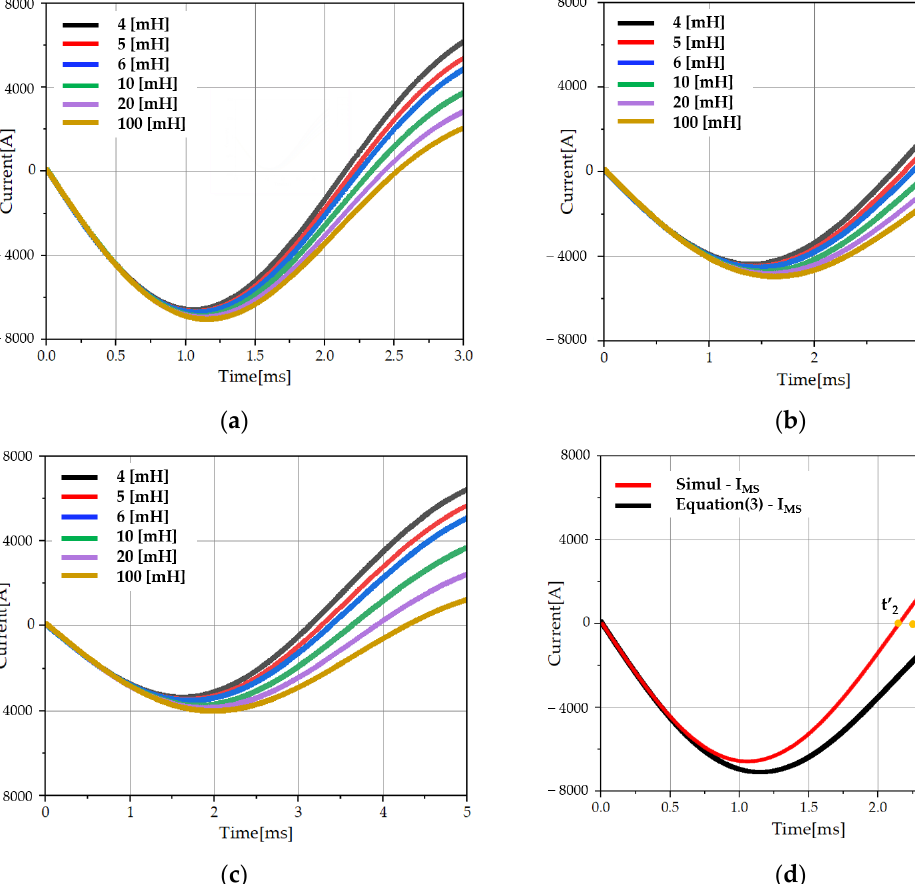
Table 2. Thomson coil operating circuit parameters.